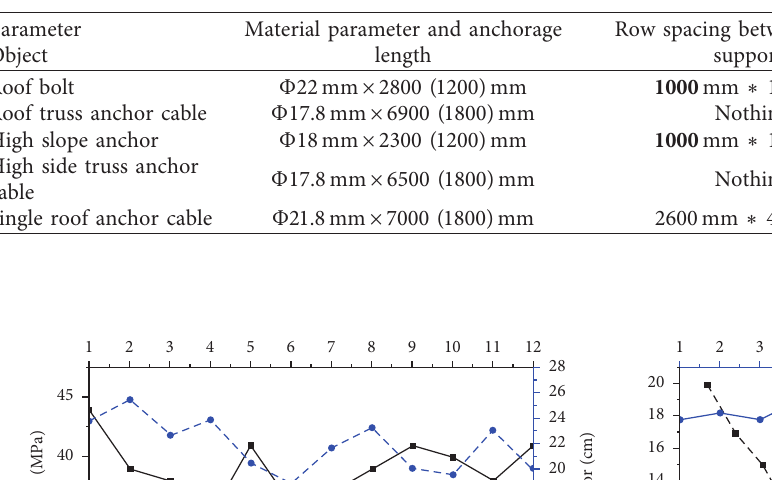
Table 2: Comparison of new and old support.